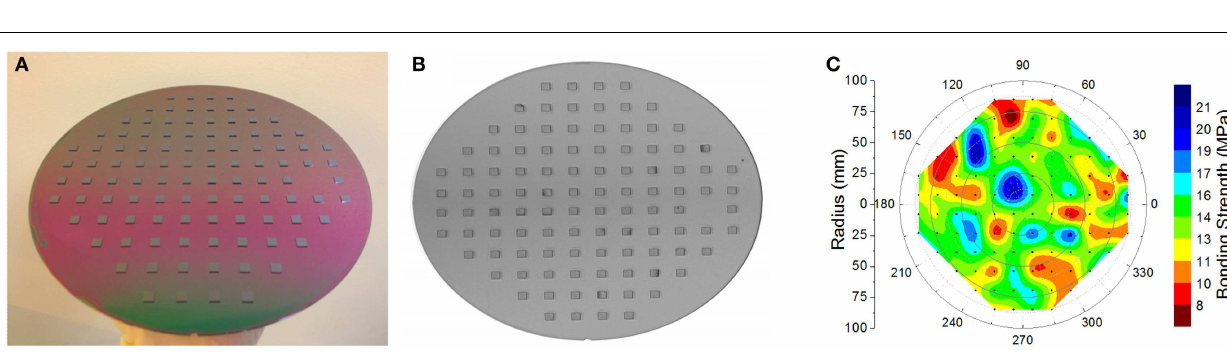
FIGURE 4 |The fabrication process flow of the multiple D2W bonding technology .The process includes two different folds, i.e., the bonding wafers preparation including the III/V dies adhesion to handle wafer for